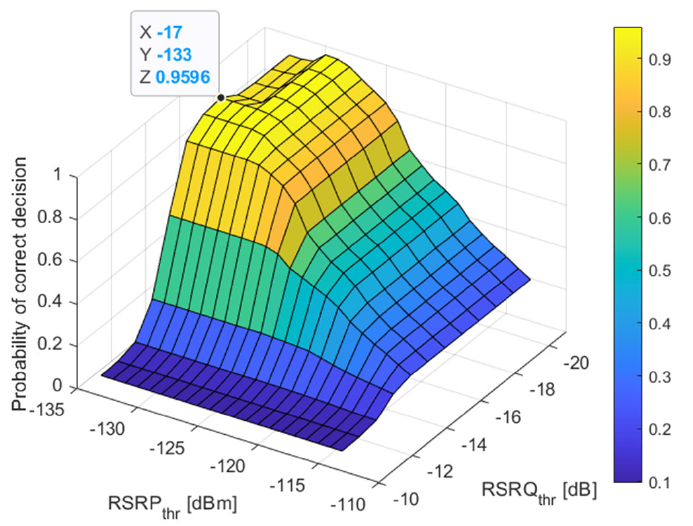
Figure 12. The probability of correct decision for different threshold values for RSRP and RSRQ while the threshold for RSSI was set to −100 dBm and the threshold for SINR was set to 0 dB.